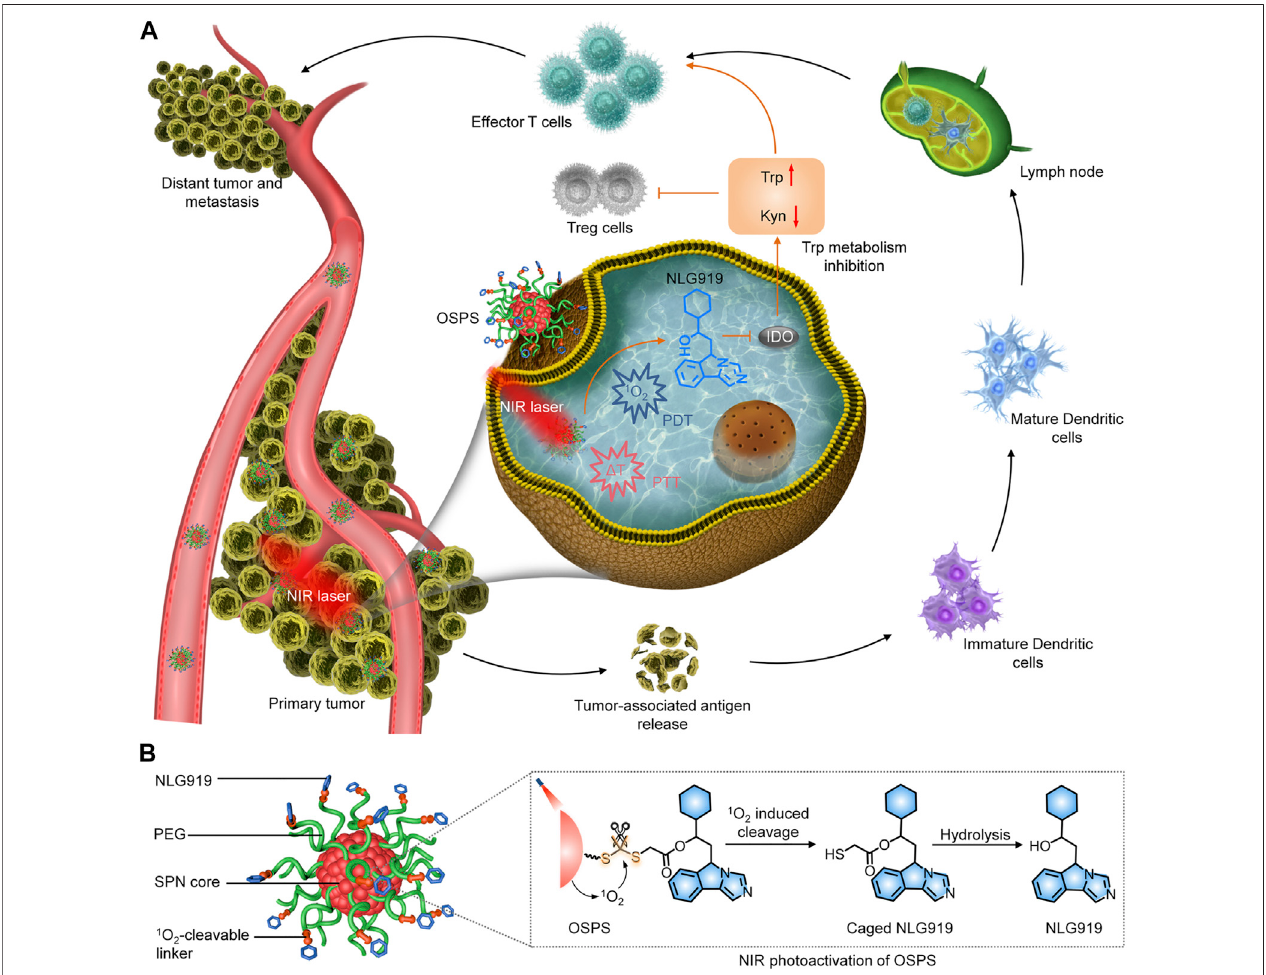
FIGURE2|(A) PhotoactivationofOSPSforsynergistictherapeuticactionincludingphototherapyandcheckpointblockadeimmunotherapy. (B) StructureandNIR photoactivation mechanism of OSPS. Reproduced, with permission, from Li et al. (2019a). Copyright 2019, John Wiley & Sons